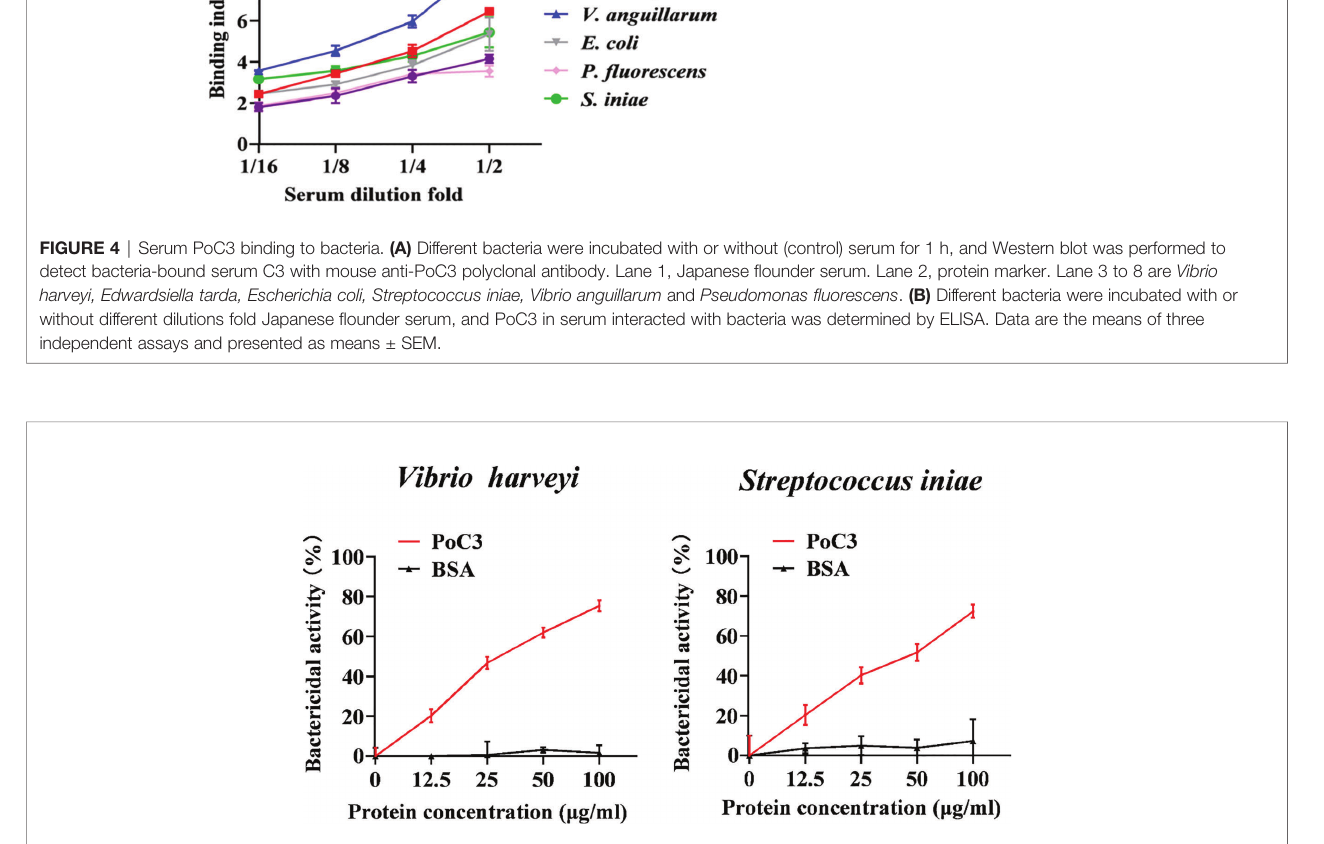
FIGURE 5 | The bactericidal activity of PoC3. Vibrio harveyi and Streptococcus iniae were incubated with or without different concentrations of PoC3 or BSA for 1 h. The bacterial survival was determined by plate count. Data are shown as means ± SEM (N = 3). N, the number of times the experiment was